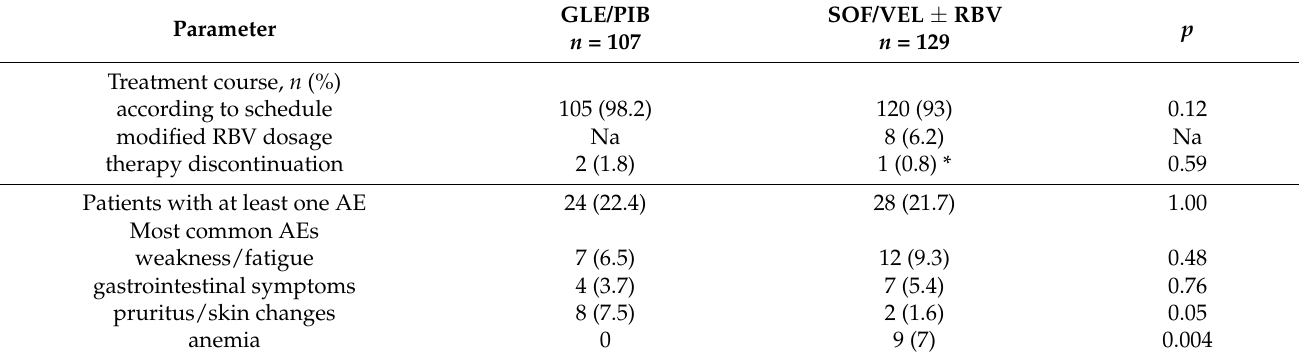
Table 9. Safety of GLE/PIB and SOF/VEL ± RBV in GT3 infected patients with liver